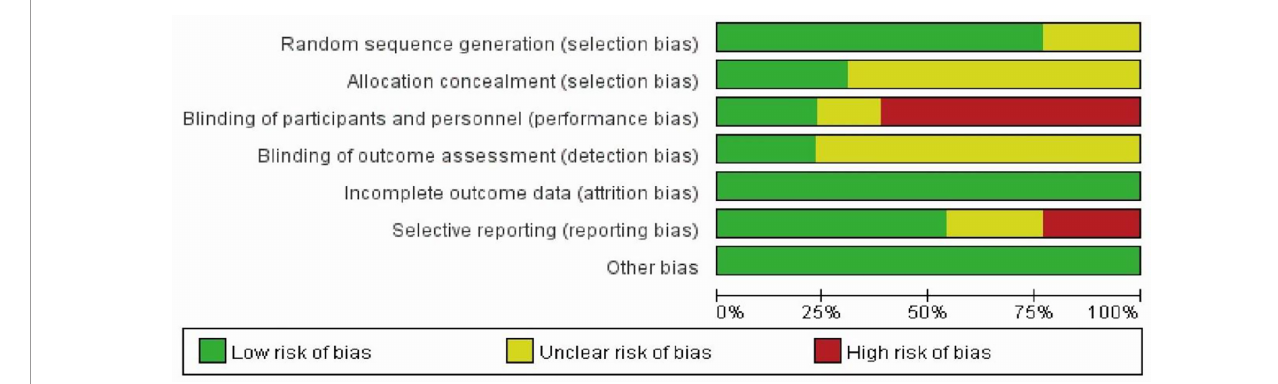
FIGURE 2 | Risk of bias for included studies.